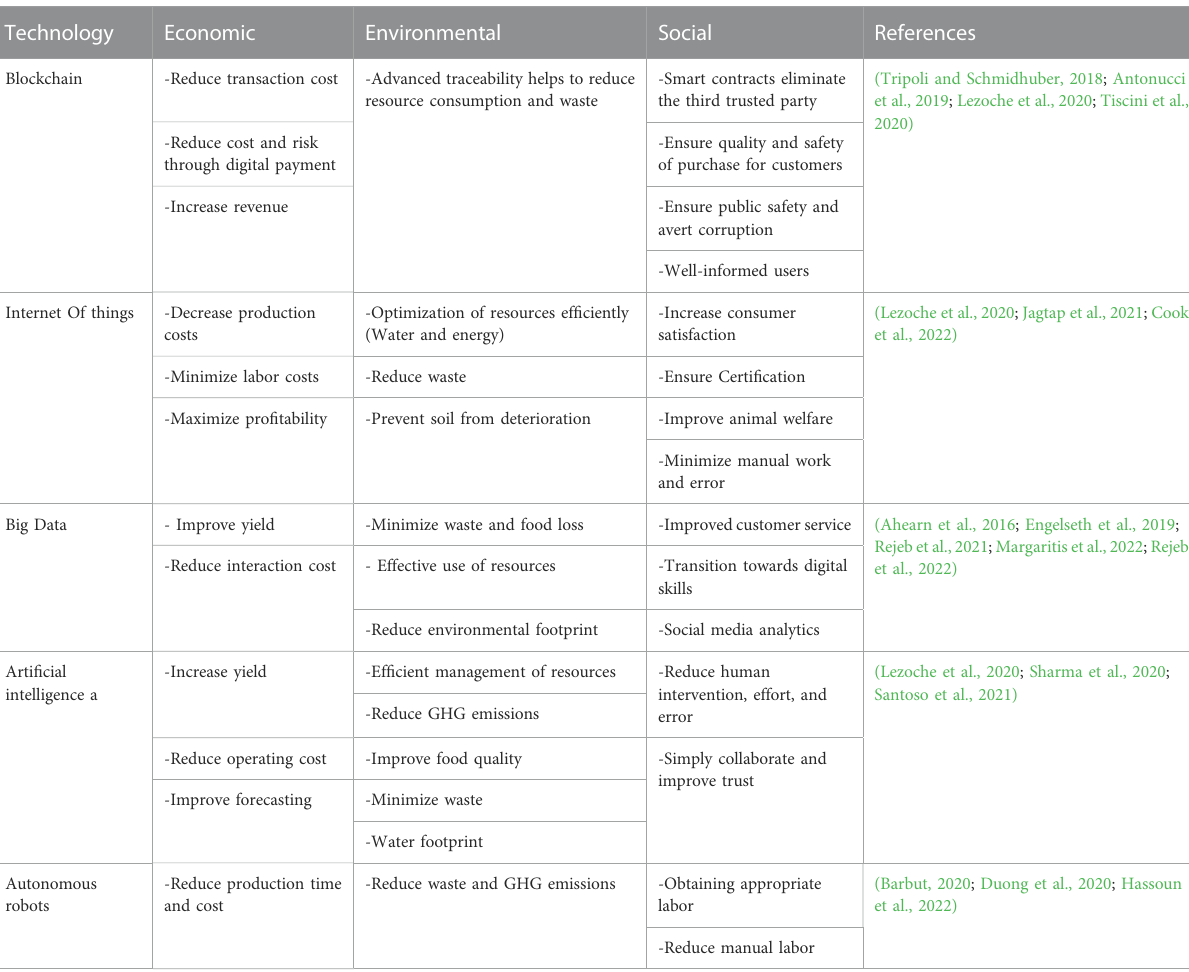
TABLE 2 Opportunities of DI toward a sustainable food